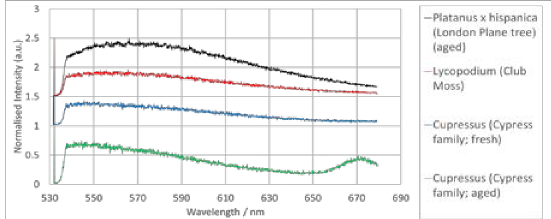
Figure 6. Fluorescence spectra of fresh and aged